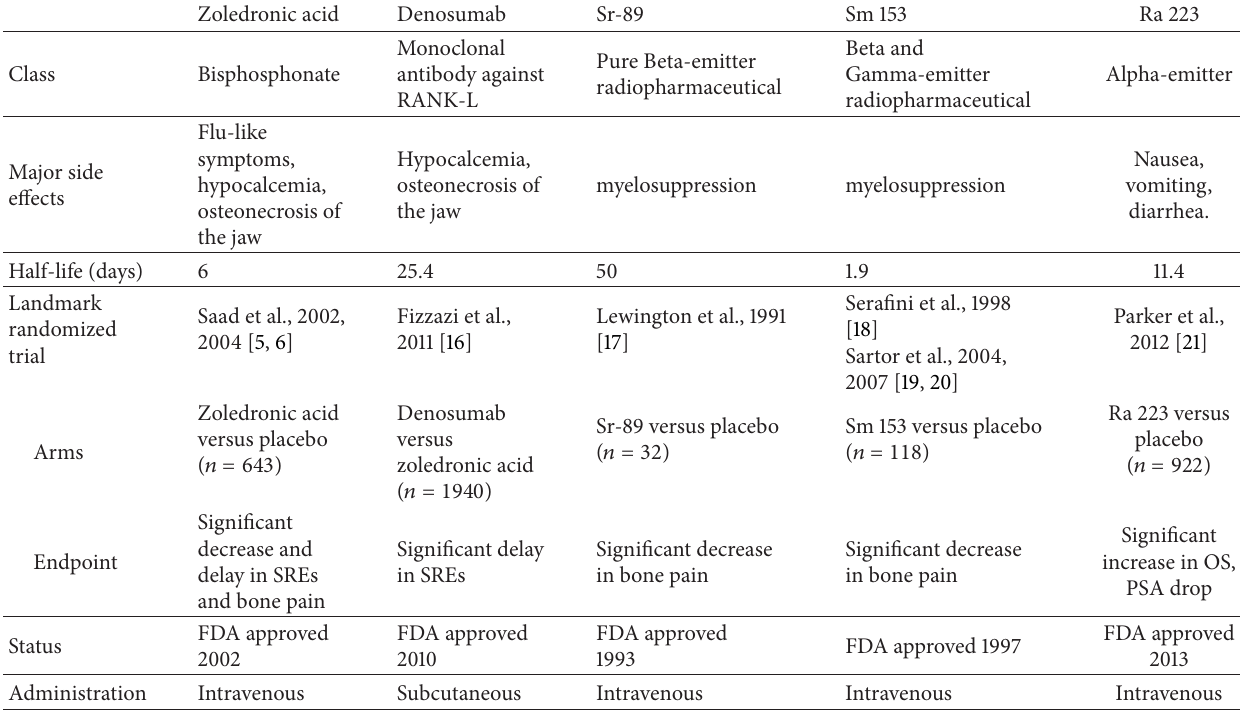
Table 1: Characteristics of selected FDA-approved bone targeting agents in